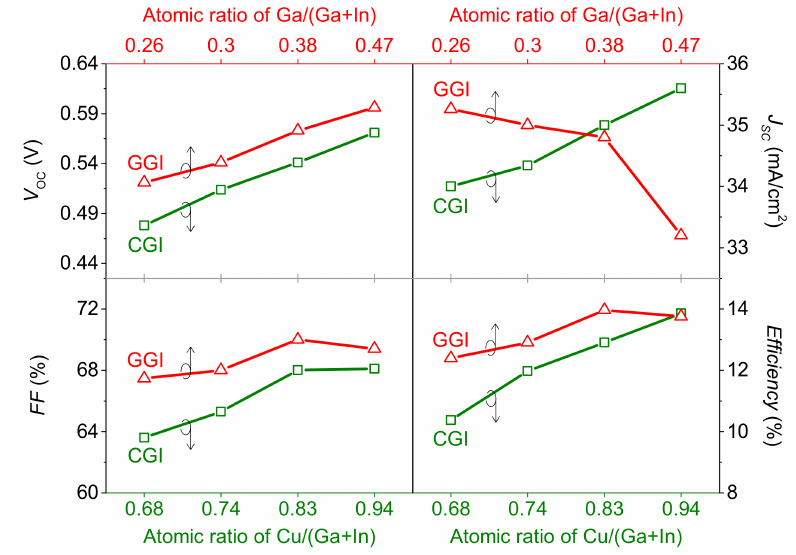
Figure 5. Dependence of performance parameters on CGI and GGI ratios of CIGS films prepared by the single-stage process.